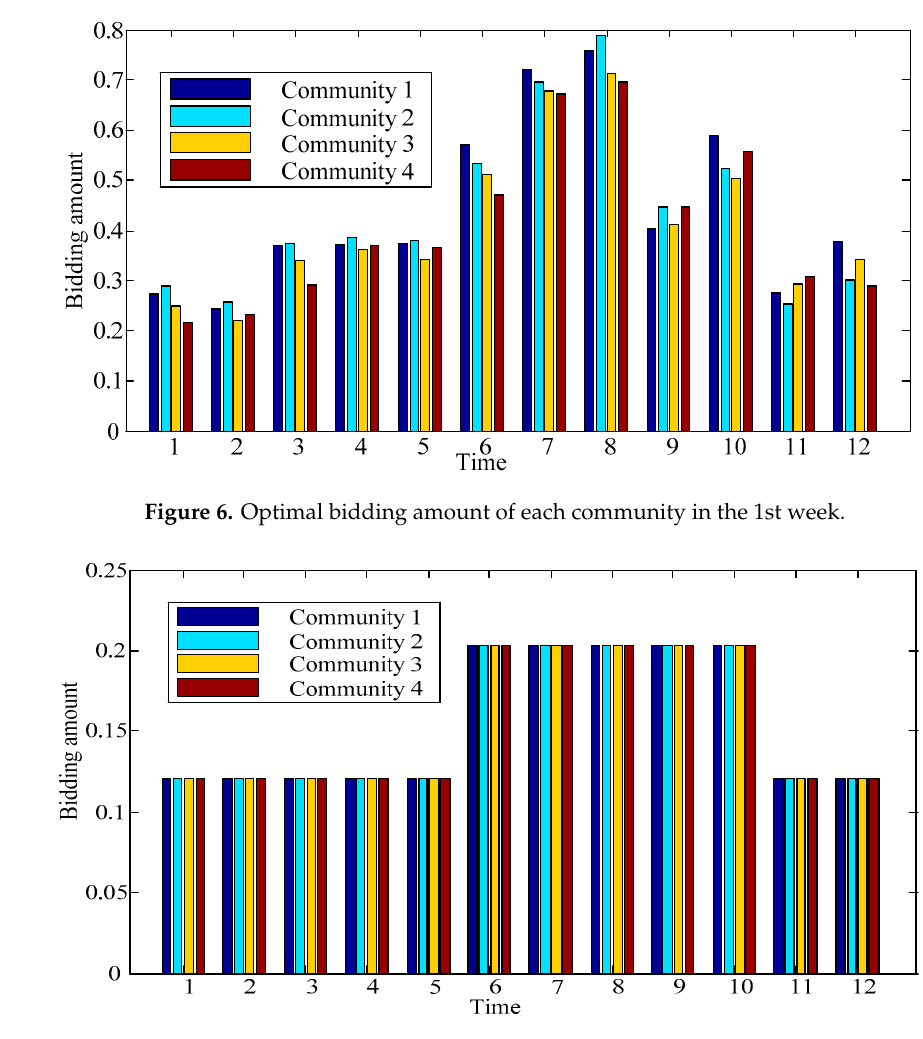
Figure 7. Optimal bidding amount of each community in the 70th week. Table 1. Average bidding amount of all communities in group